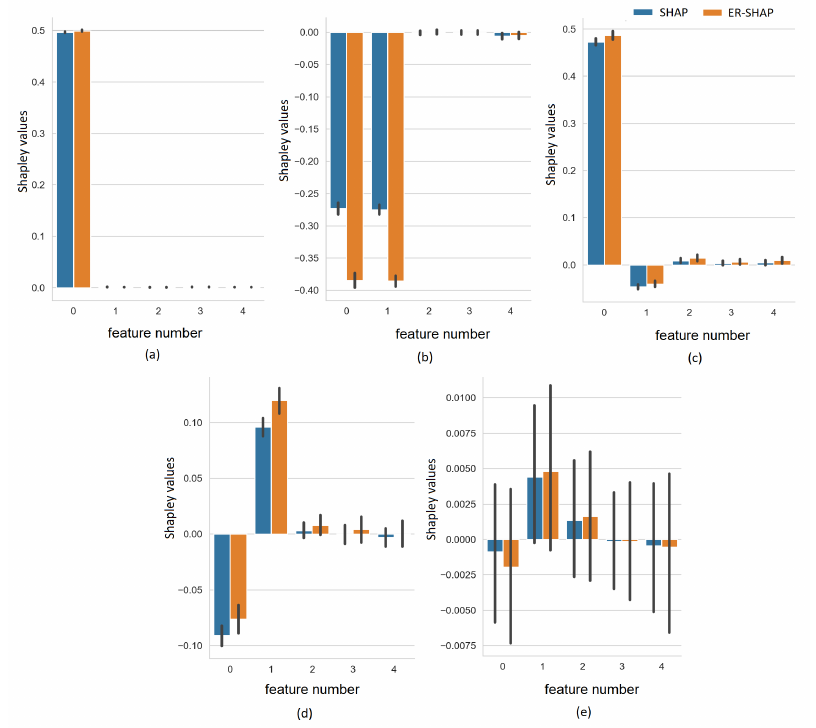
Figure 11. Shapley values obtained by means of SHAP and ERW-SHAP for all features of five datasets depicted in corresponding Figure 4a–e and trained SVMs under condition of using the normal distribution of feature changes with the standard deviation